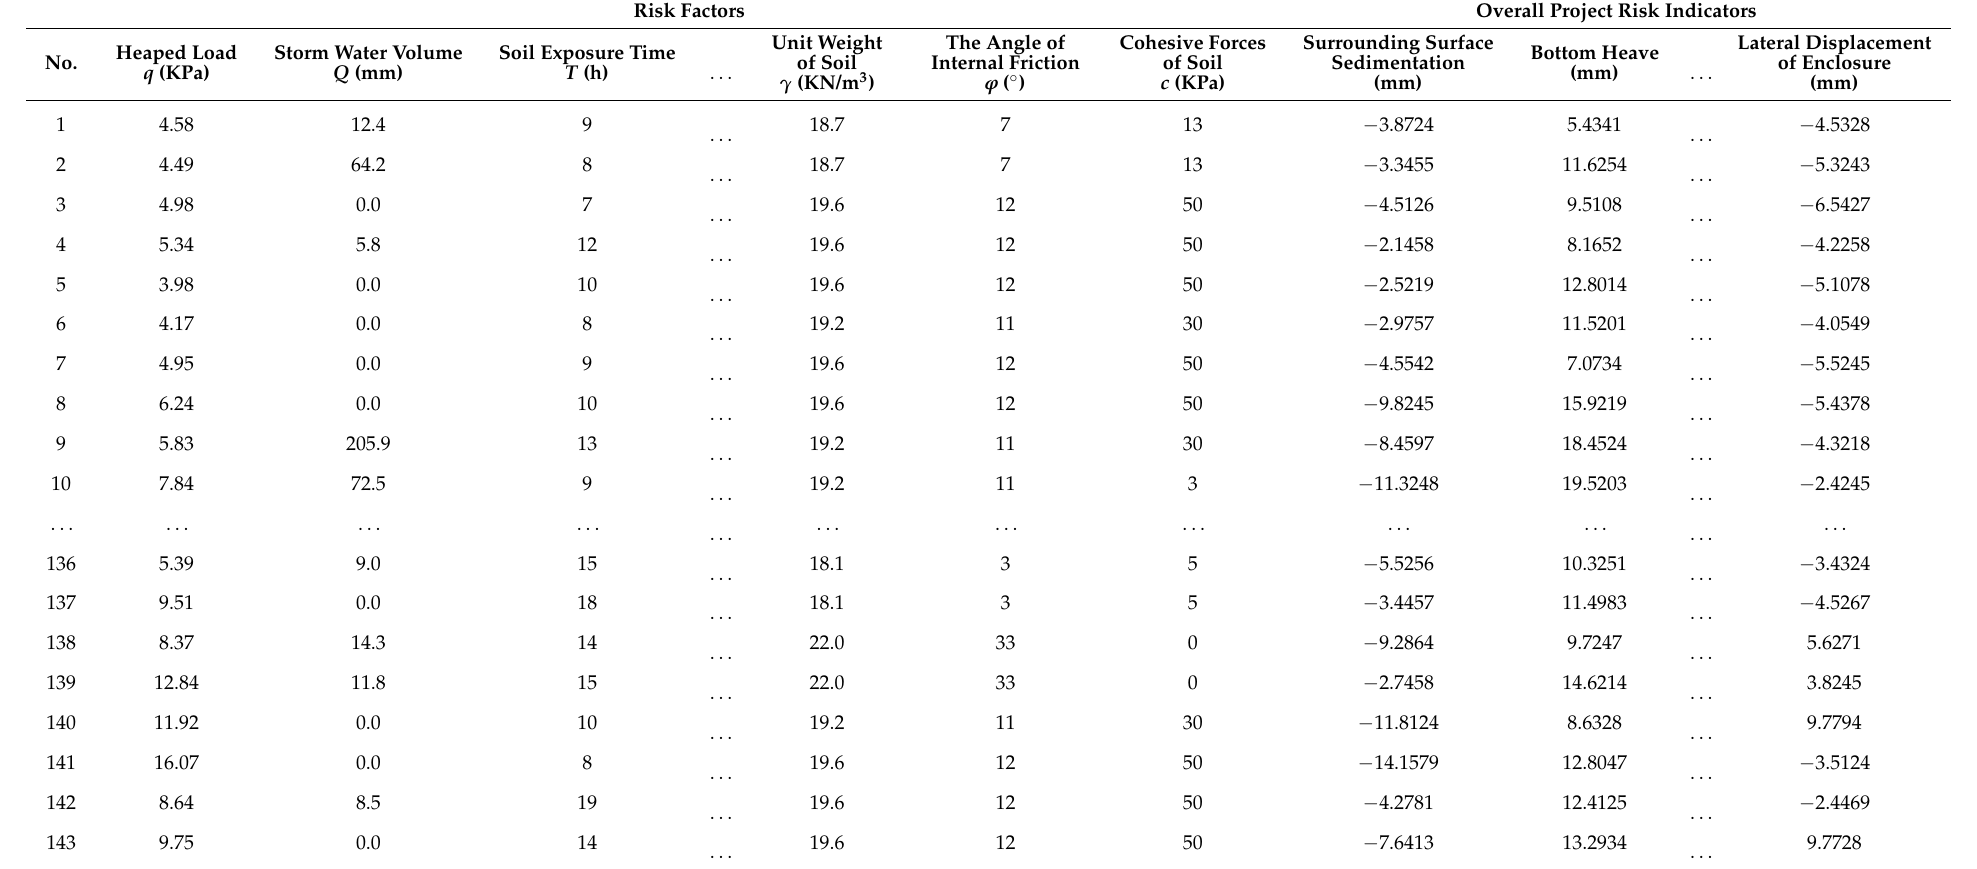
Table 1. Original monitoring